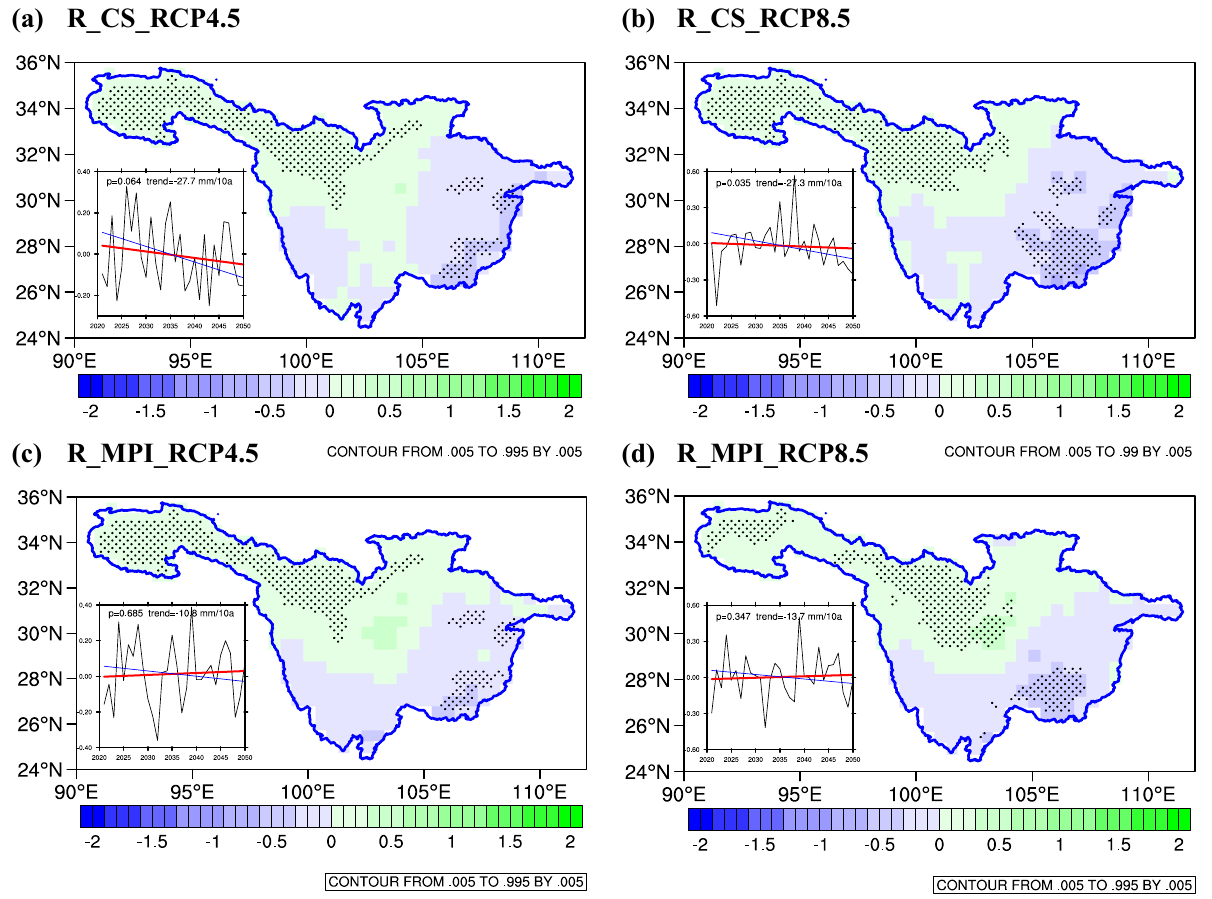
Figure 8. Multiyear average changes (unit: mm/day) in precipitation over the UYRB under the RCP4.5 and RCP8.5 scenarios compared to the reference period (1971–2000). The black dots denote differences that are statistically significant at a significance level of 95% based on Student’s t-test. The rectangle indicates the interannual variation trend of precipitation anomalies (unit: mm/day). The figure was prepared using The